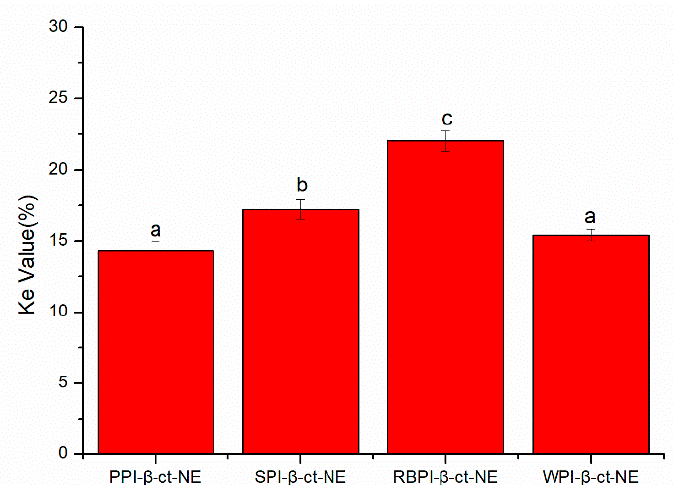
Figure 4. Ke values of PPI-, SPI-, RBPI-, and WPI-stabilized nanoemulsions. a–d represent statistically significant differences ( p < 0.05) between PPI-, SPI-, RBPI-, and WPI-stabilized nanoemulsions, in terms of Ke values.